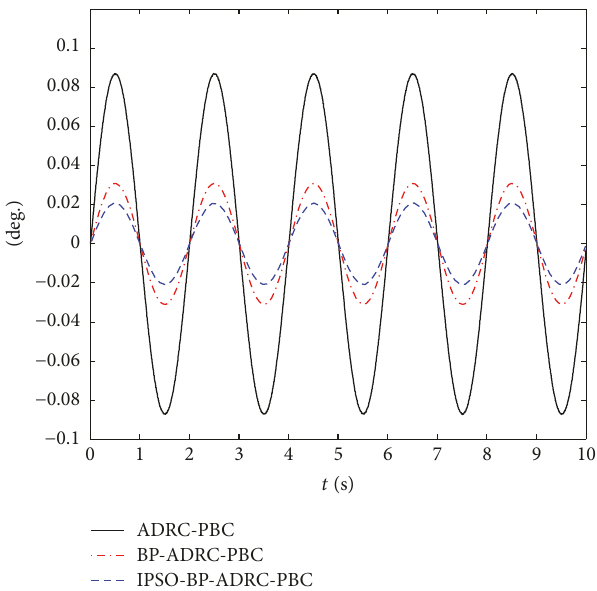
Figure 10: Tracking error curve of the system.